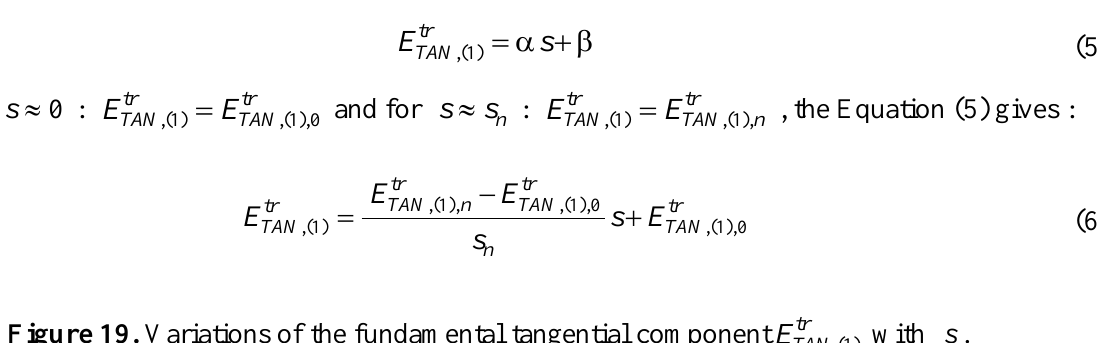
Figure 19. Variations of the fundamental tangential component tr